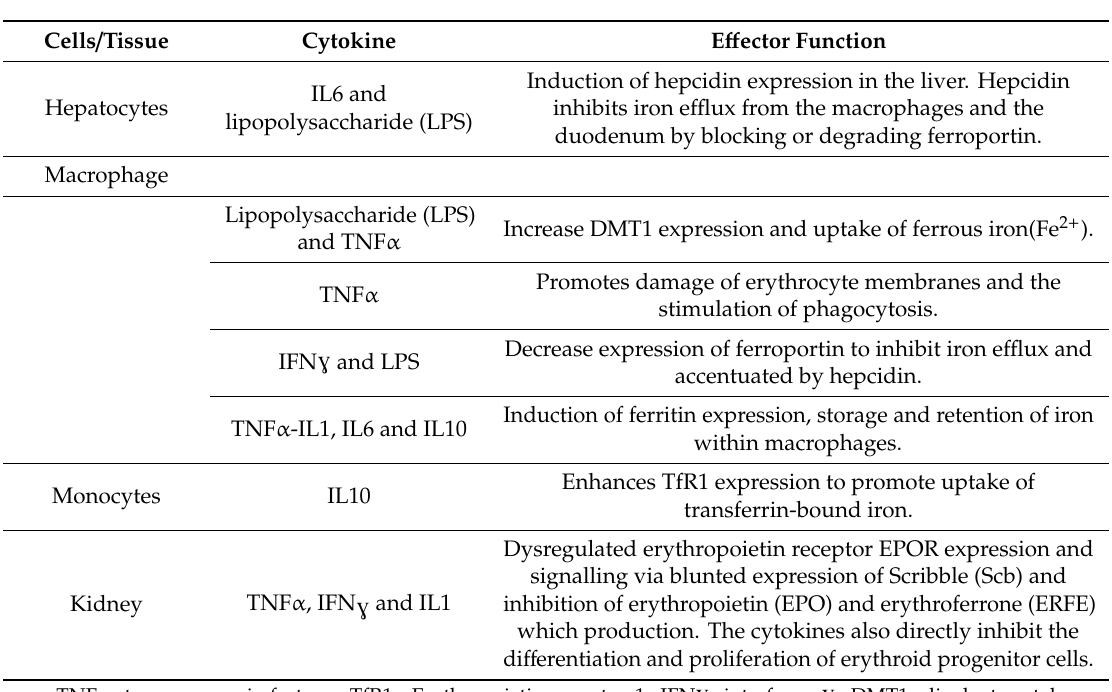
Table 1. Features of anemia of inflammation [17].